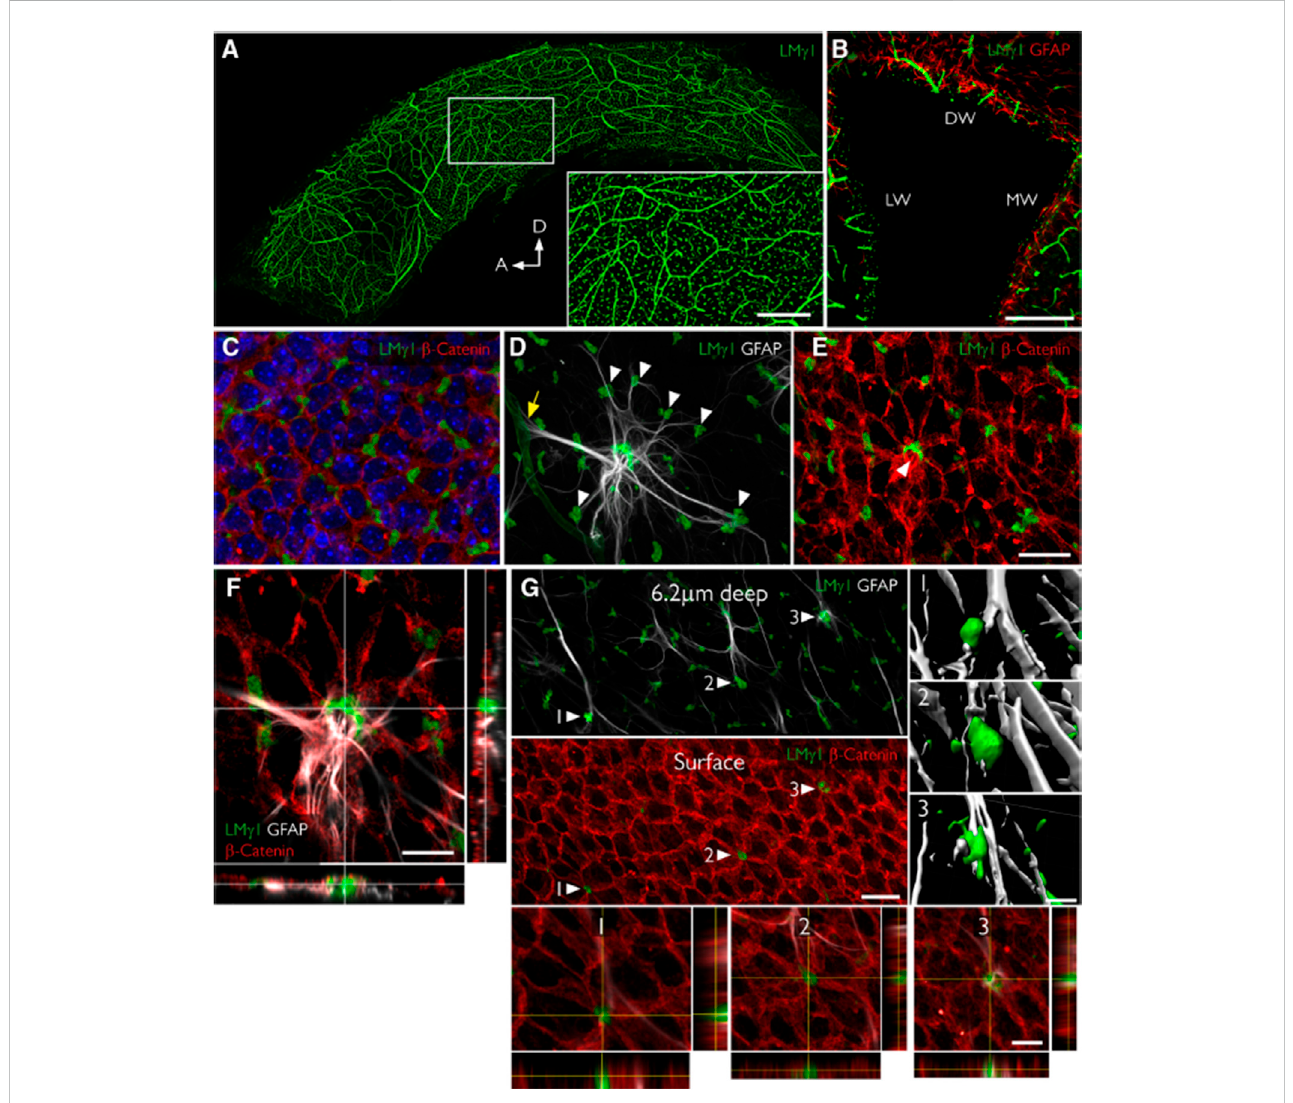
FIGURE 4 Fractones are a major BM source in the SVZ and appear at the center of pinwheels. (A) , Whole mount of the lateral wall of the lateral ventricle of an adult mouse immuno fl uorescently stained for laminin γ 1 (green). The frontal view reveals the profuse distribution of fractone bulbs. A higher magni fi cation of the boxedareaisdepictedintheinset. (B) ,Coronalsectionthroughthelateralventricle,showingtheuniformdistributionoflaminin γ 1+fractonebulbs(green)on all three walls: dorsal wall (DW), lateral wall (LW), and medial wall (MW). (C) , Frontal view of the ependymal cell layer, seen at 1 μ m depth relative to the ventricular surface, stained for laminin γ 1 (green) to visualizefractones and β -catenin (red)to visualize cell junctions in the ependymal layer. All fractone bulbs sit at the interface between cells. (D) , Maximum intensity projection of a Z-stack of a whole mount showing a GFAP + NSC (gray) in contact with one blood vessel(yellow arrow) and > 10 fractone bulbs (arrowheads)atthesame time. (E) , Theneuralstem cell bodyalso contactsalarge bulblocated atthecenterofa pinwheel(arrowhead). (F) ,OrthogonalviewsrevealingthattheNSC – fractoneinteractionseenin (C,D) occursatthesurfaceofapinwheelcenter. (G) ,GFAP+ processes contact more bulbs at pinwheel centers (arrowheads) than bulbs at the basolateral surface of ependymal cells. Interactions between GFAP + processes and fractone bulbs were labeled 1 – 3 and rendered, revealing that GFAP + processes establish direct and complex contacts with fractones. Orthogonal views of these interactions con fi rm that fractone bulbs sit between ependymal cells at pinwheel centers and that GFAP + processes directly contactthem.Scalebars: (A) ,500 μ m; (A) ,inset,200 μ m; (B) ,200 μ m; (C – E) ,25 μ m; (F) ,12 μ m; (G) ,25 μ m; (G) ,1 – 3,12 μ m.Adaptedfrom(Nascimentoetal., 2018) with